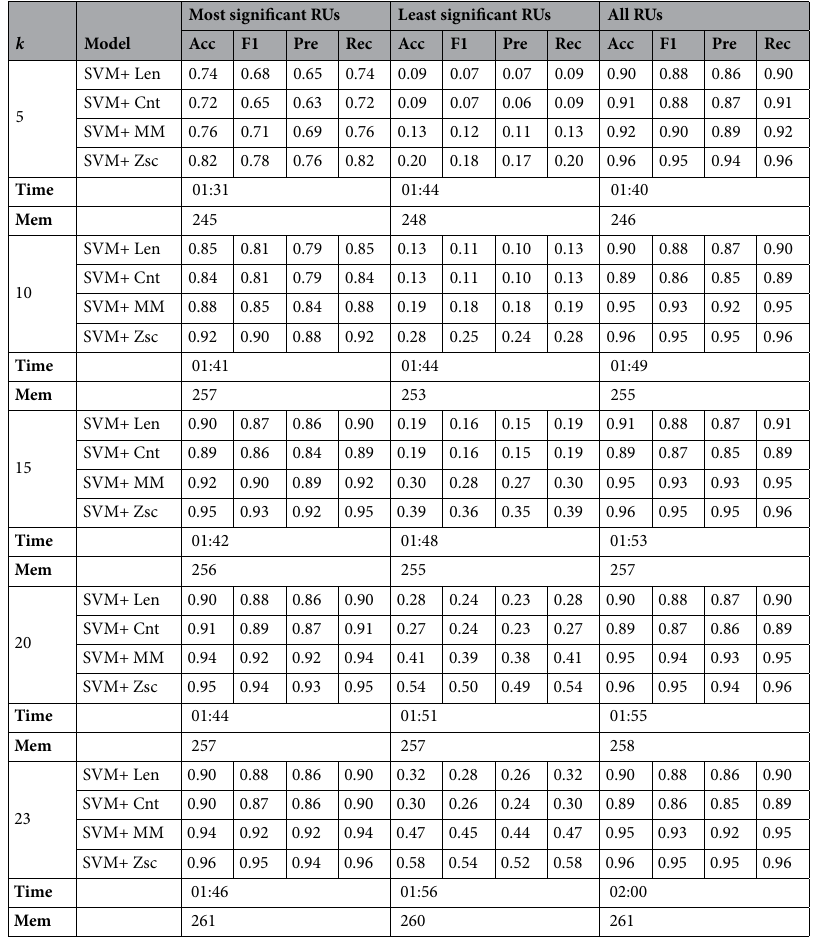
Table 3. Effect of varying the top k features on NEU test sets. Accuracy indicated by Acc, F1-score indicated by F1, Precision indicated by Pre, and Recall indicated by Rec. Also, the time is reported in the format mm:ss while the peak memory usage is in